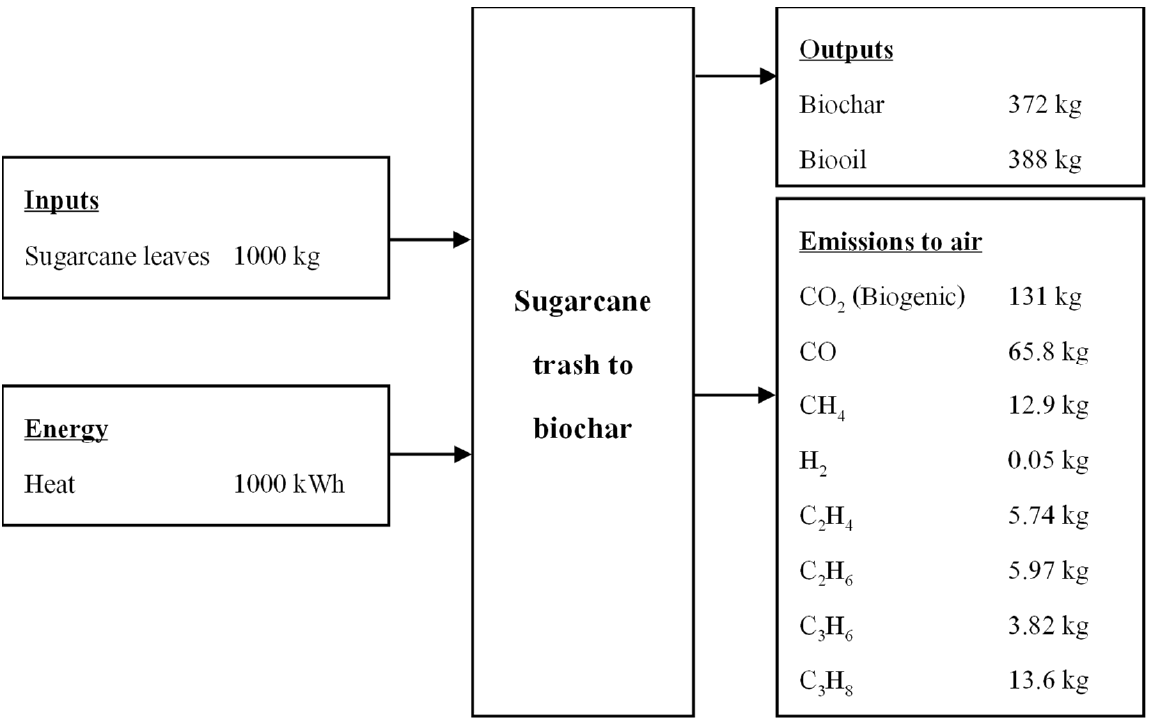
Figure A3. Inputs-Outputs of Scenario SL2: Cane trash to biochar. Remark: Data is referred from [50].